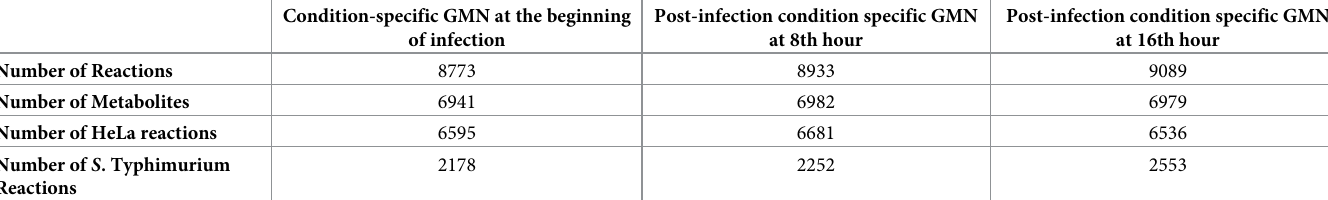
Table 1. The reaction and metabolite numbers of condition specific pathogen-host GMN